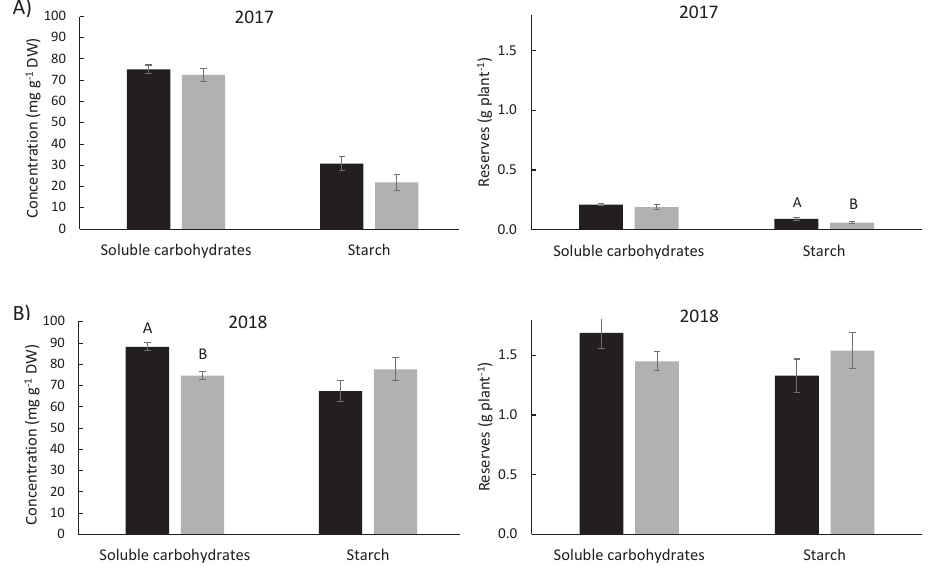
Fig. 5. Soluble carbohydrate and starch concentrations and reserves on 6 November 2017 (A) and 2018 (B) in strawberry cv. Wendy crowns with or without fall row cover installed on 28 August 2017 and 12 September 2018. Vertical bars represent ± SEM, n = 5. Values marked with different letters are significantly different at p <